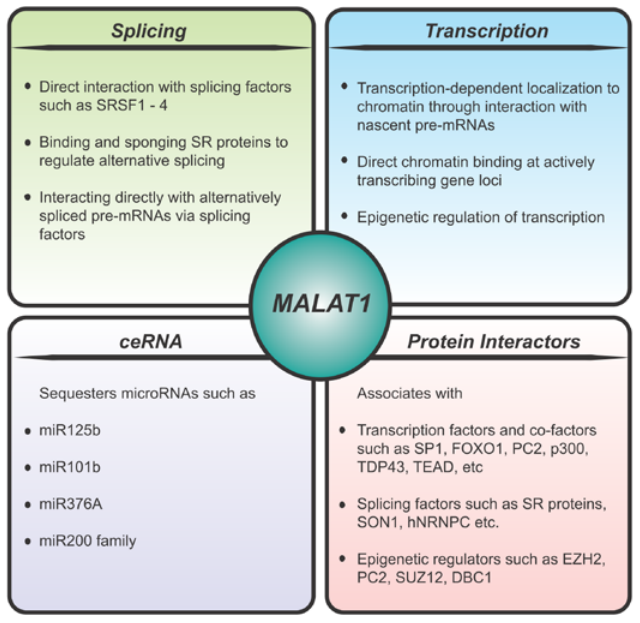
Figure 1. Molecular mechanisms of MALAT1 function.